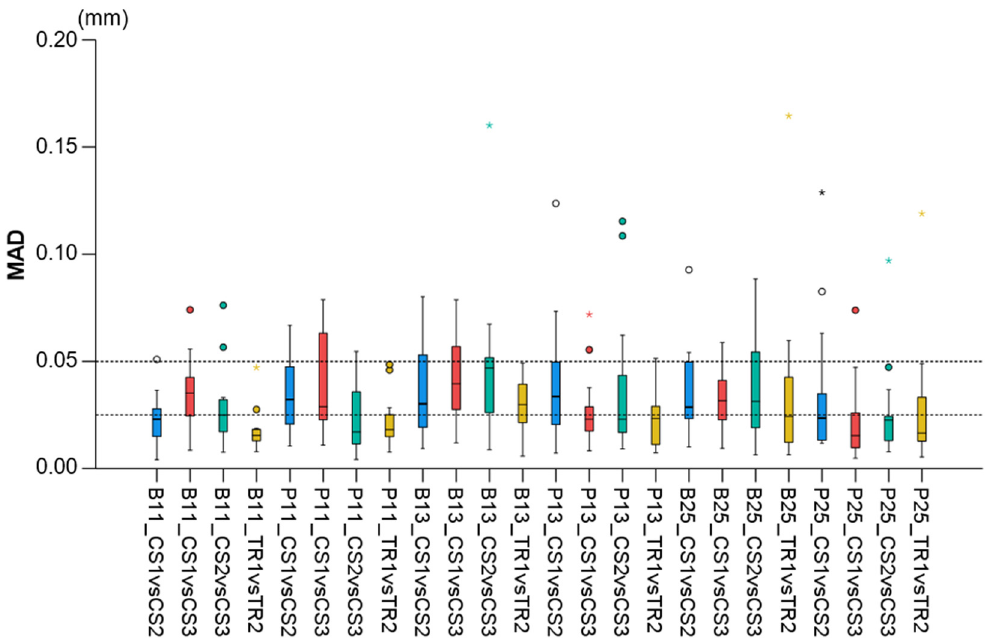
Figure 6. Box plots showing the precision of the intraoral scanners at prespecified circular areas located 2 mm apical to the deepest point of the gingival margin area of teeth #11, #13, and #25 on the buccal (B11, B13, B25) and palatal sides (P11, P13, P25). The upper limit of the black line represents the maximum value, the lower limit represents the minimum value, the box represents the interquartile range, and the horizontal line represents the median value. Outliers are shown as circles or stars in more extreme cases. The dashed horizontal lines indicate 0.025 and 0.05 mm MAD (Mean Absolute Distance) between the compared